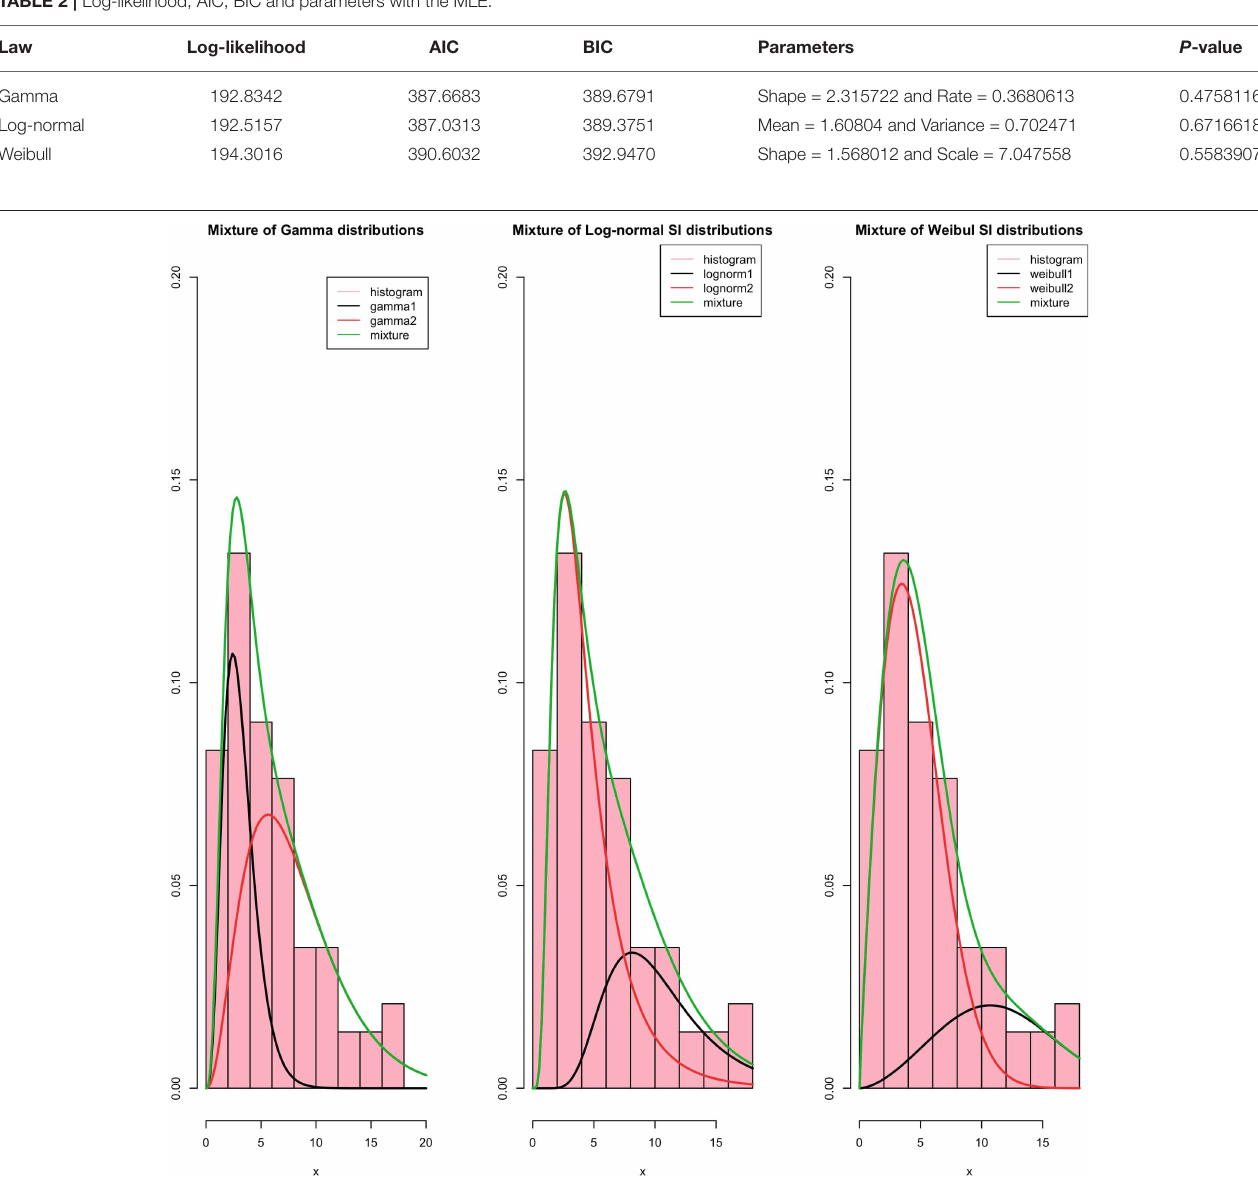
FIGURE 4 | Mixture distribution by the Optim